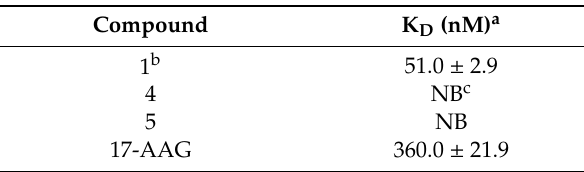
Table 1. Thermodynamic constants measured by surface plasmon resonance (SPR) for the interaction between the tested compounds and immobilized Hsp90 α